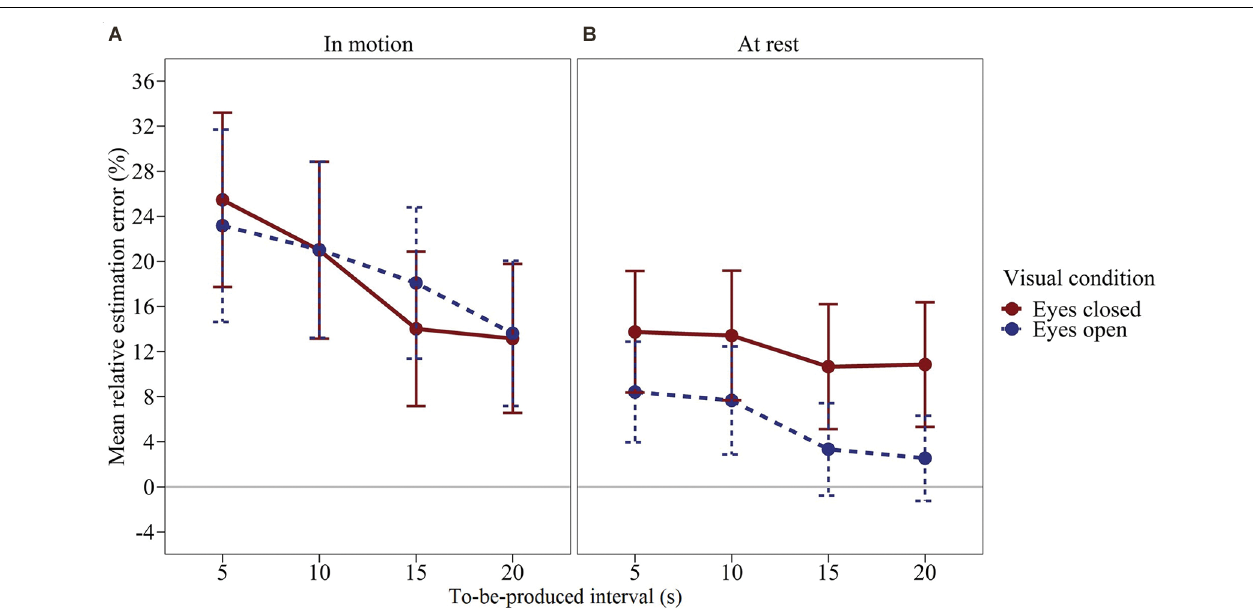
FIGURE 4 | Mean relative estimation error of to-be-produced intervals by visual condition for each vestibular stimulation condition of Experiment 3. (A) Swing in motion, (B) Swing at rest. Error bars represent ± 1 standard error of the mean (SEM). Values above 0 indicate relative overproduction of the